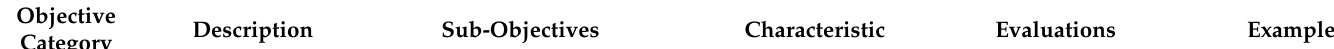
Table 2. A summary of objective categories of developing GD in